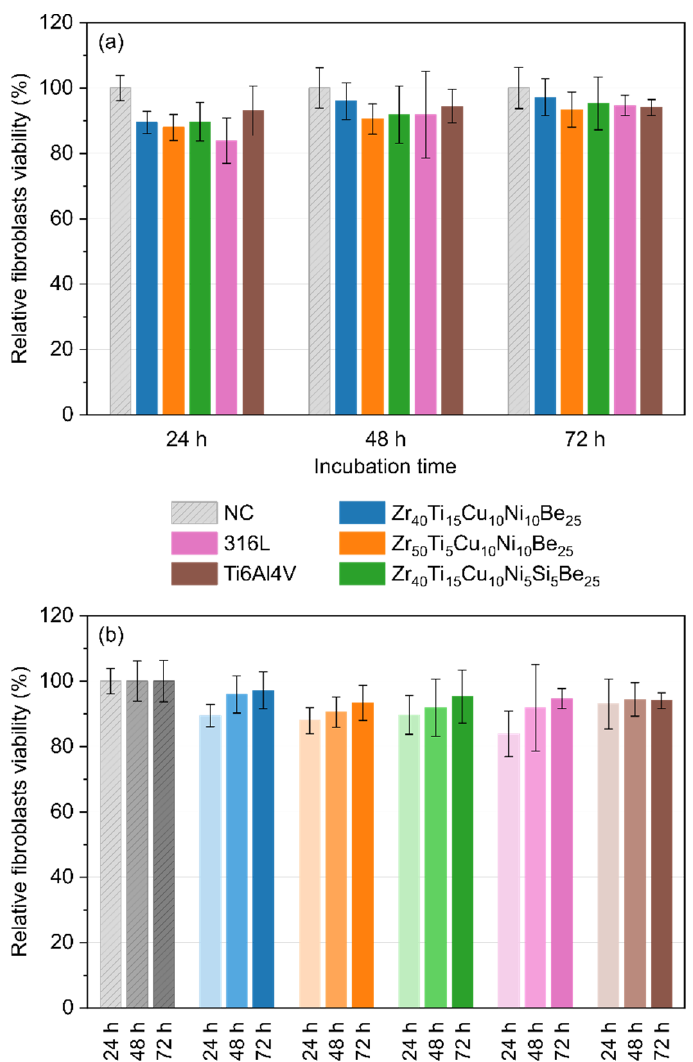
Figure 5. Relative viability and proliferation of fibroblasts (IMR90 cell line) in direct contact with Zr 40 Ti 15 Cu 10 Ni 10 Be 25 , Zr 50 Ti 5 Cu 10 Ni 10 Be 25 , Zr 40 Ti 15 Cu 10 Ni 5 Si 5 Be 25 alloys, 316L stainless steel, and Ti6Al4V alloy assessed by MTT assay carried out at 24 h, 48 h, and 72 h time intervals—compatison between samples at the same incubation time ( a ), and influence of incubation time for each material ( b ). Cell viability of untreated cells (NC) was taken as 100%.